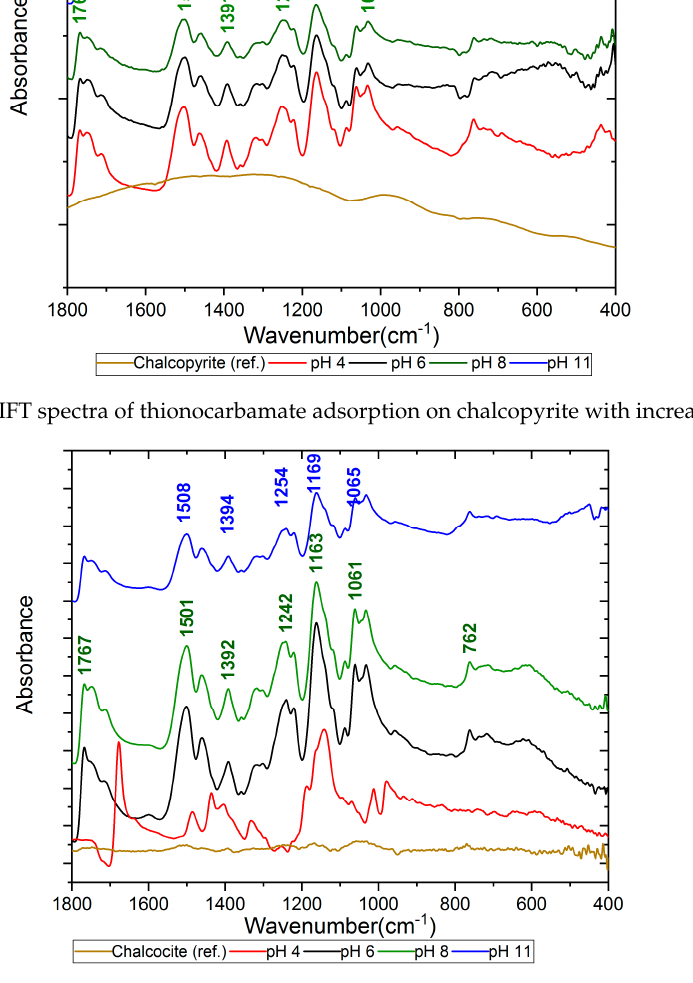
Figure 13. DRIFT spectra of thionocarbamate adsorption on chalcocite with increasing pH.